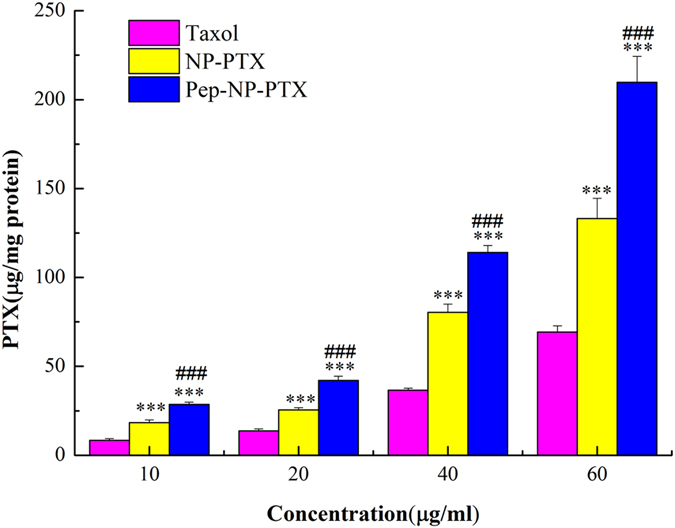
Cellular uptake of PTX-loaded NP and Pep-NP at 37 °C after incubation for 2 h at the PTX concentrations from 10 μg/mL to 60 μg/mL in C6 cells.Data represented mean ± SD (n = 3). ***p < 0.001 significantly higher than that of Taxol®, ###p < 0.001 significantly higher than that of NP-PTX.